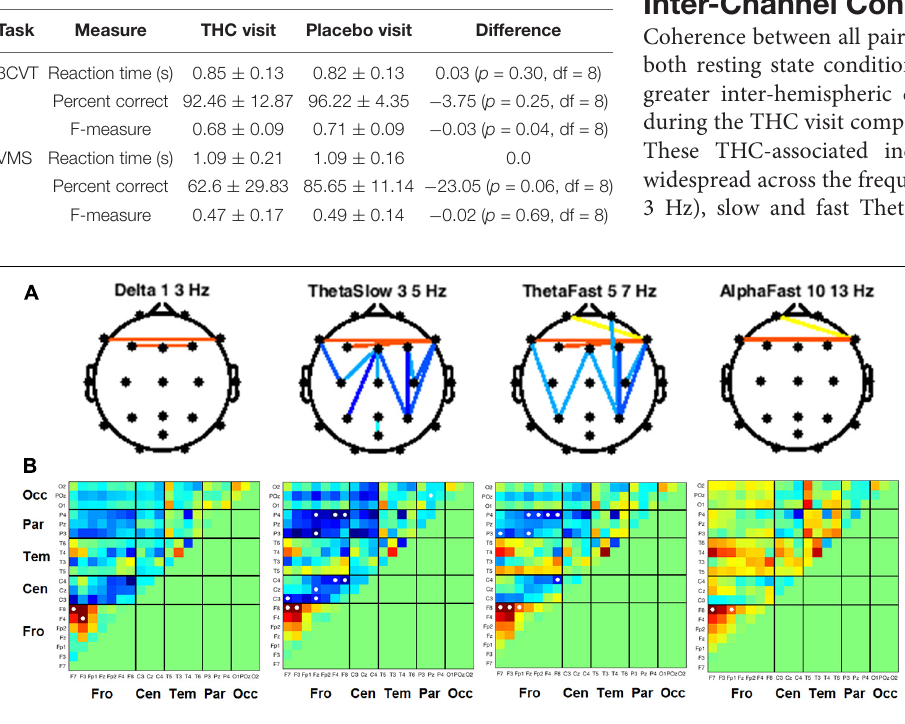
FIGURE 7 | Inter-channel coherence differences between visits. Resting state eyes closed. THC visit was associated with increased coherence between inter-hemispheric frontal channels and coherence reductions along fronto-posterior axis. (A) Topographic maps by frequency band. (B) Accompanying heat maps of coherence by frequency band for all channel pairs. Significant pairs at α = 0.05 marked with white circles. Duplicate channel pair data below diagonal in heat map matrices have been set to zero (green) to facilitate visualization of results. Channels grouped together by region. Occ, occipital channels; Par, parietal channels; Tem, temporal channels; Cen, central channels; Fro, frontal